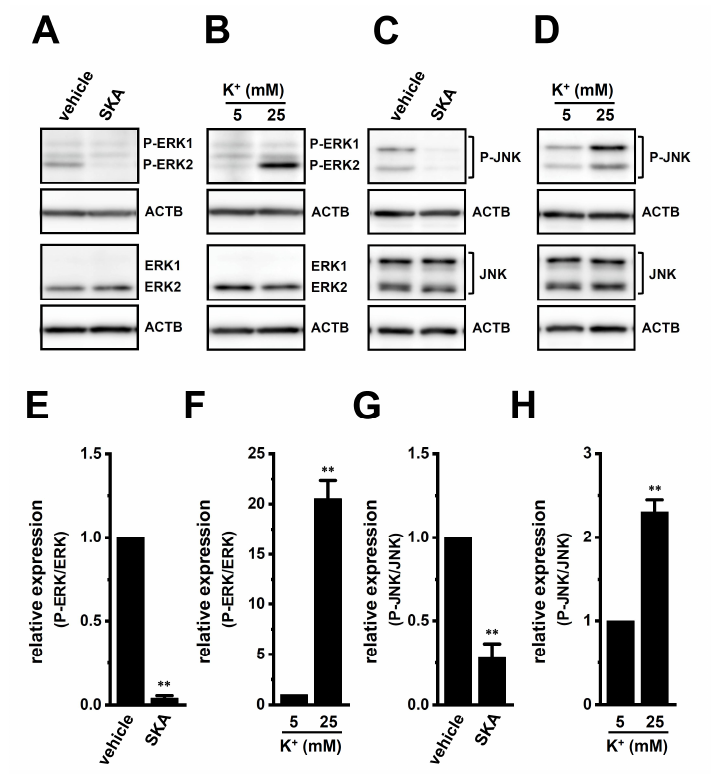
Figure 7. Protein expression levels of phosphorylated ERK1/2 (P-ERK1/2) and P-JNK in THP-1-derived M 2 macrophages following the SKA-121 treatment and high [K + ] e exposure. A – D : Western blot showing P-ERK1/2, total ERK1/2 (ERK1/2) ( A,B ), P-JNK, and total JNK (JNK) ( C , D ) in 1 µ M SKA-121-treated ( A , C ) and high [K + ] e -exposed ( B , D ) THP-1-derived M 2 macrophages. Specific band signals were observed at 42 (P-ERK2), 42 (ERK2), 43/50 (P-JNK), and 43/50 (JNK) kDa. E – H : Summarized results of the relative protein expression of P-ERK2/ERK2 ( E , F ) and P-JNK/JNK ( G , H ) in 1 µ M SKA-121-treated ( E , G ) and high [K + ] e -exposed ( F , H ) THP-1-derived M 2 macrophages. After compensation with the optical density of the ACTB signal (43 kDa), the expression level in the vehicle control or 5 mM K + is expressed as 1.0 (n = 4 for each). **: p < 0.01 vs. the vehicle control and 5 mM K + .